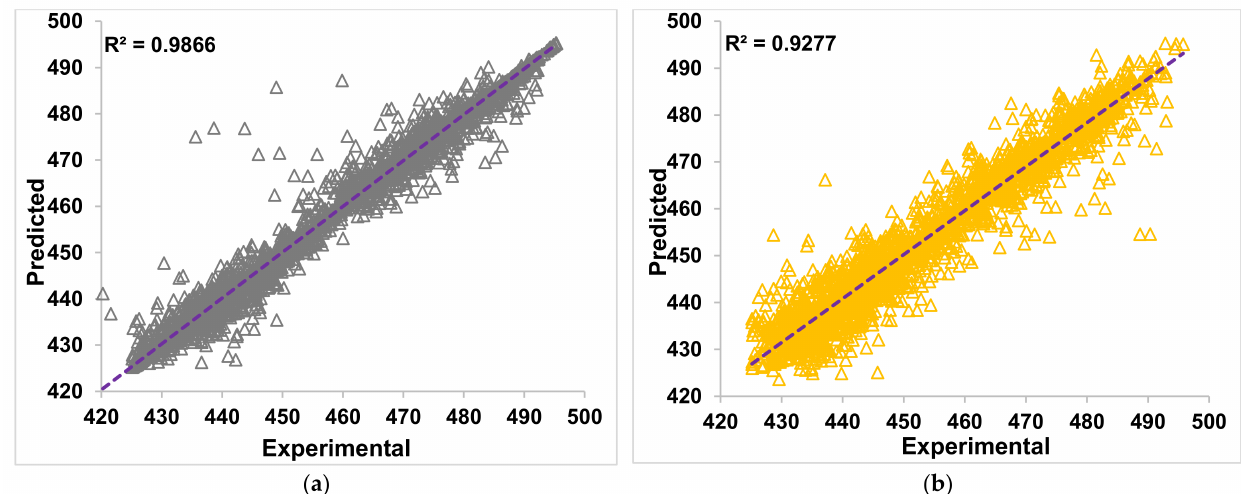
Figure 13. SVR-based radial basis function—SVR (RBF) algorithm ( a ) Training and ( b ) testing results for the CCPP energy